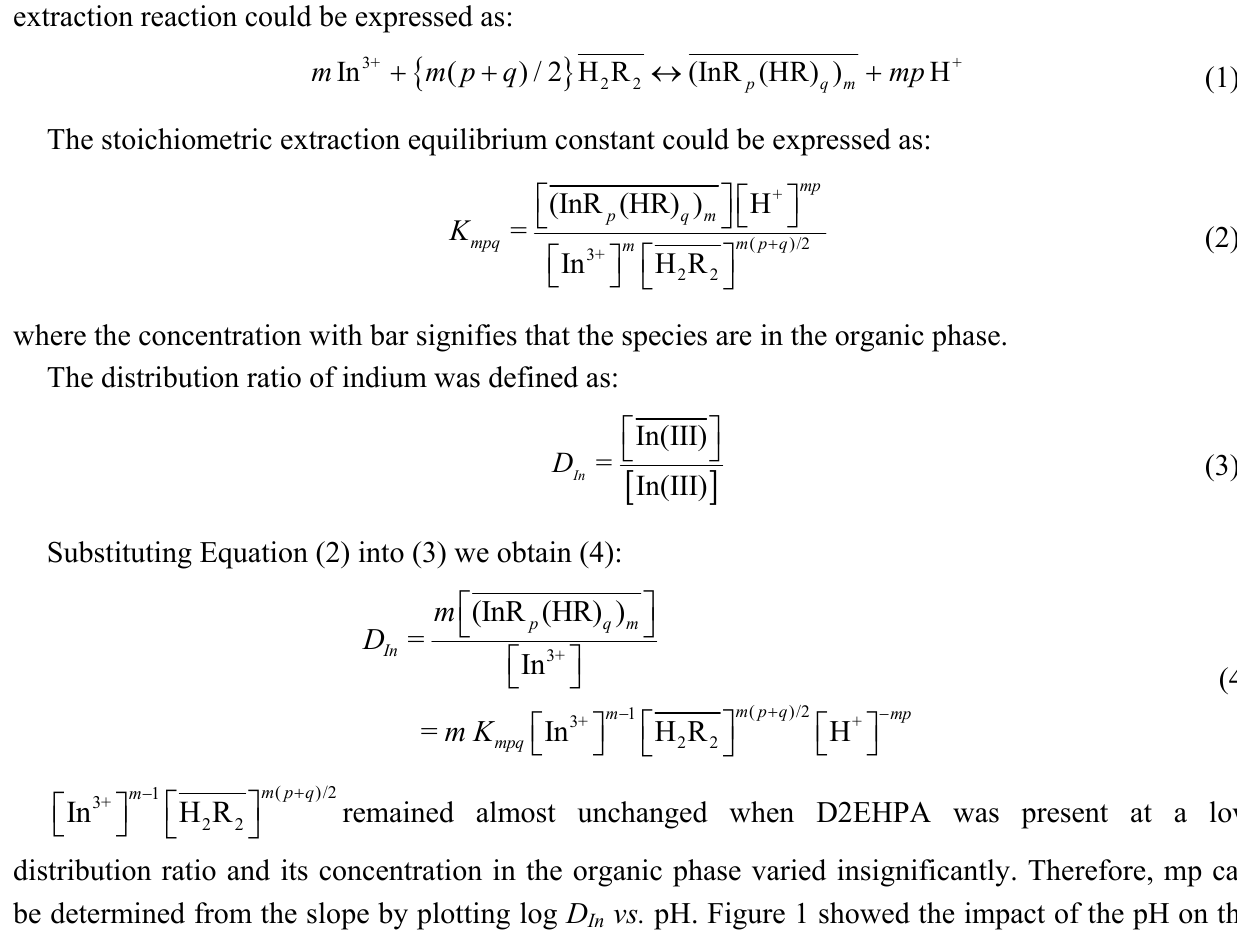
Figure 1. Relationships of log D concentrations in kerosene at 25  C. [In 3+ ]